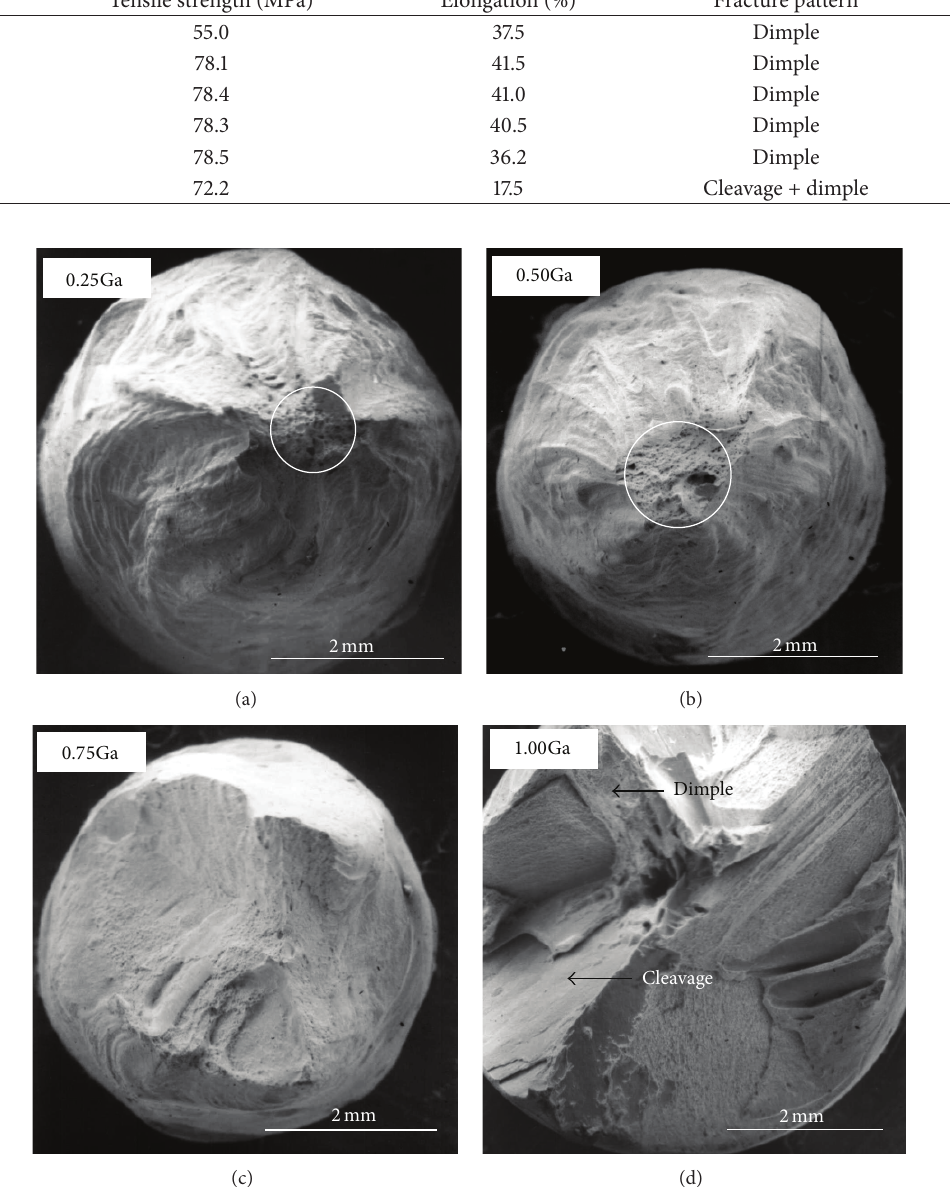
Figure 7: The fracture surfaces of the Sn-9Zn-0.25Ga, Sn-9Zn-0.50Ga, Sn-9Zn-0.75Ga, and Sn-9Zn-1.00Ga solder alloys.